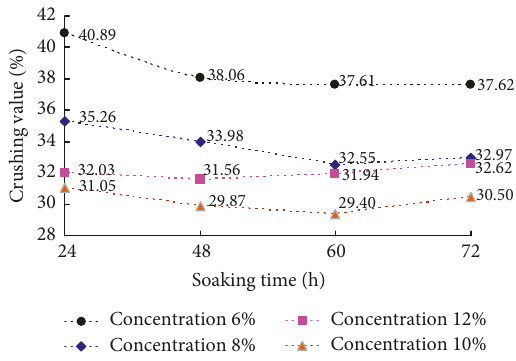
Figure 14: Crushing value of